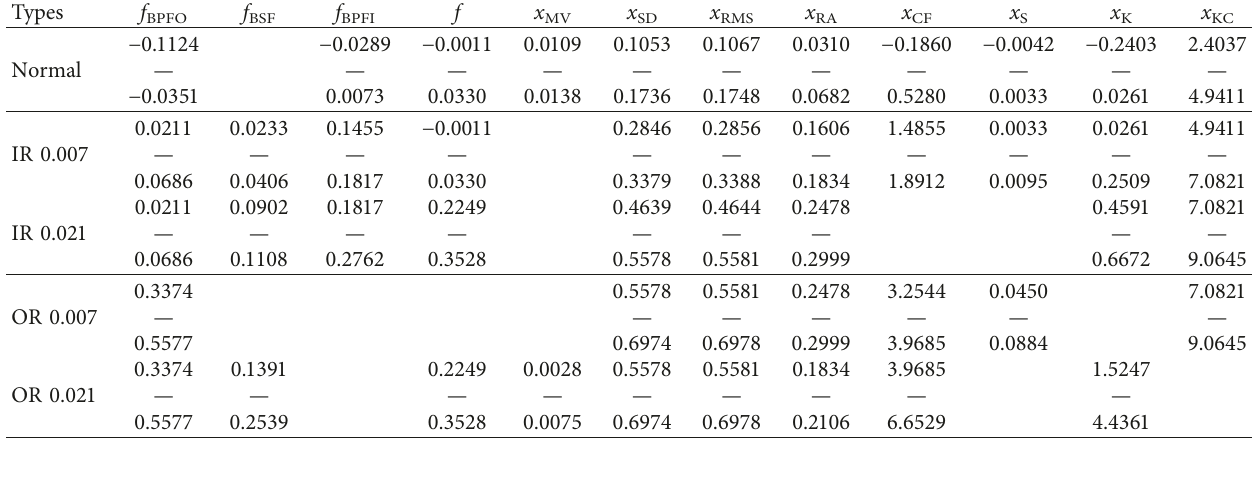
Table 7: The range of eigenvalues in different fault sizes.